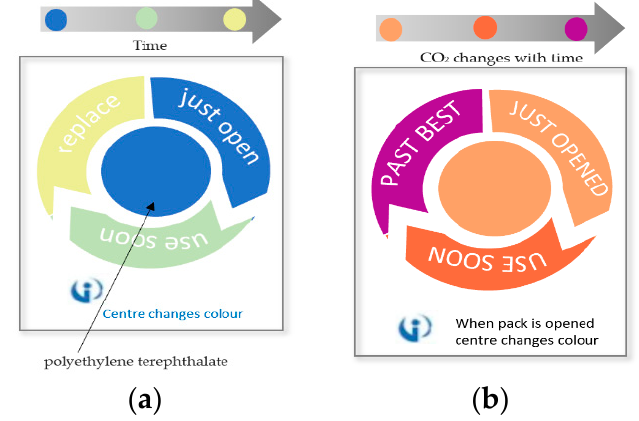
Figure 15. ( a ) Food Fresh TM indicator. ( b ) Monitor Mark indicator.